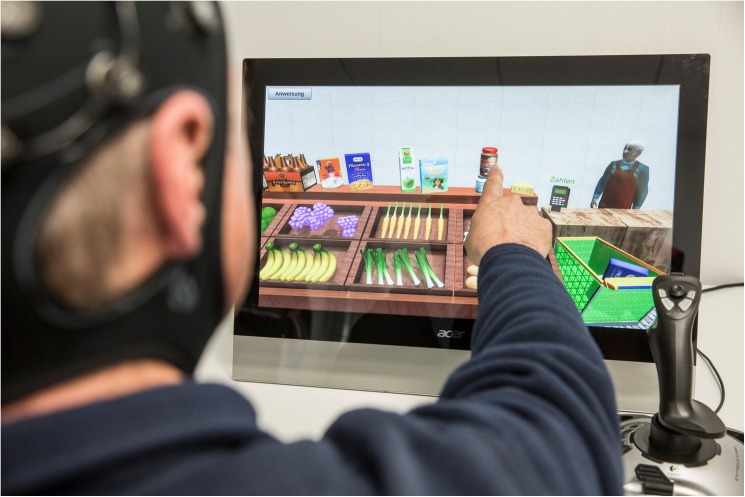
Participant during the experiment, picking an ingredient during the shopping task.(Participant on the picture gave written informed consent to be photographed for publication).